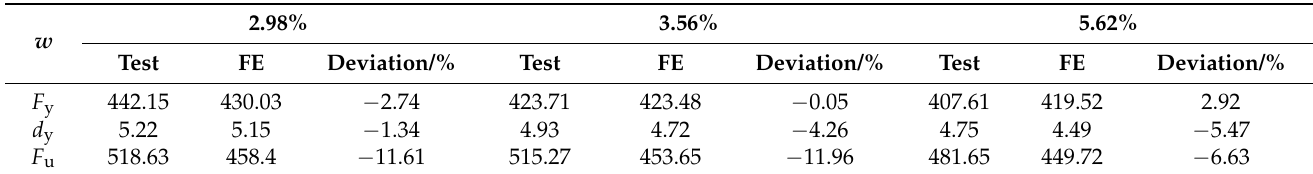
Table 12. Comparison of the FE and test results.